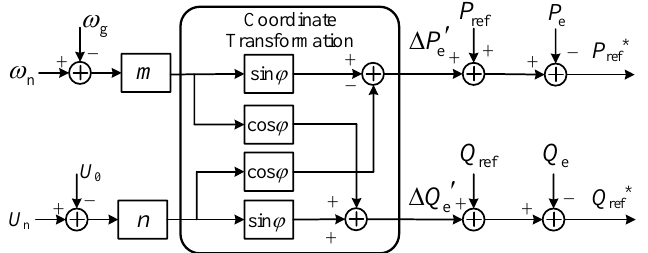
Figure 5. The block diagram of the improved droop control based on virtual coordinate transformation.